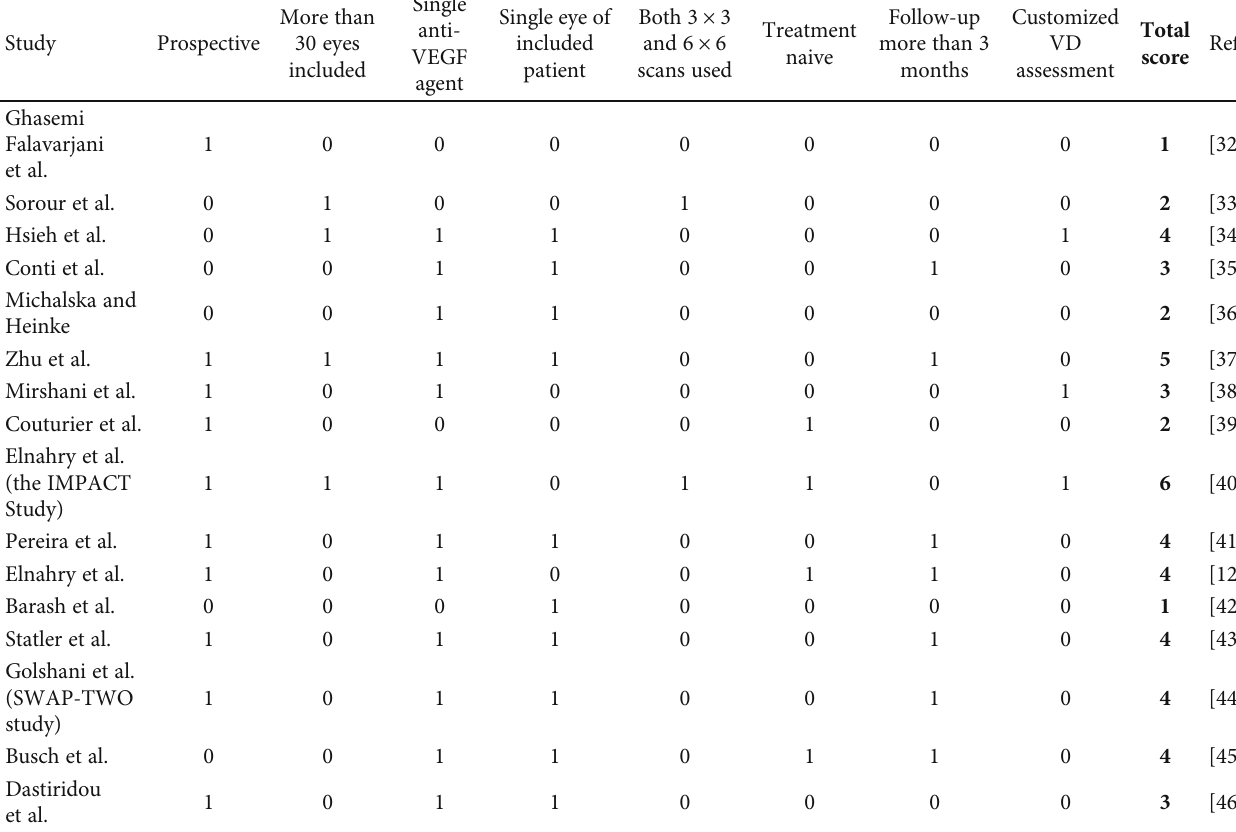
Table 5: A customized scale for assessing and comparing the quality of included